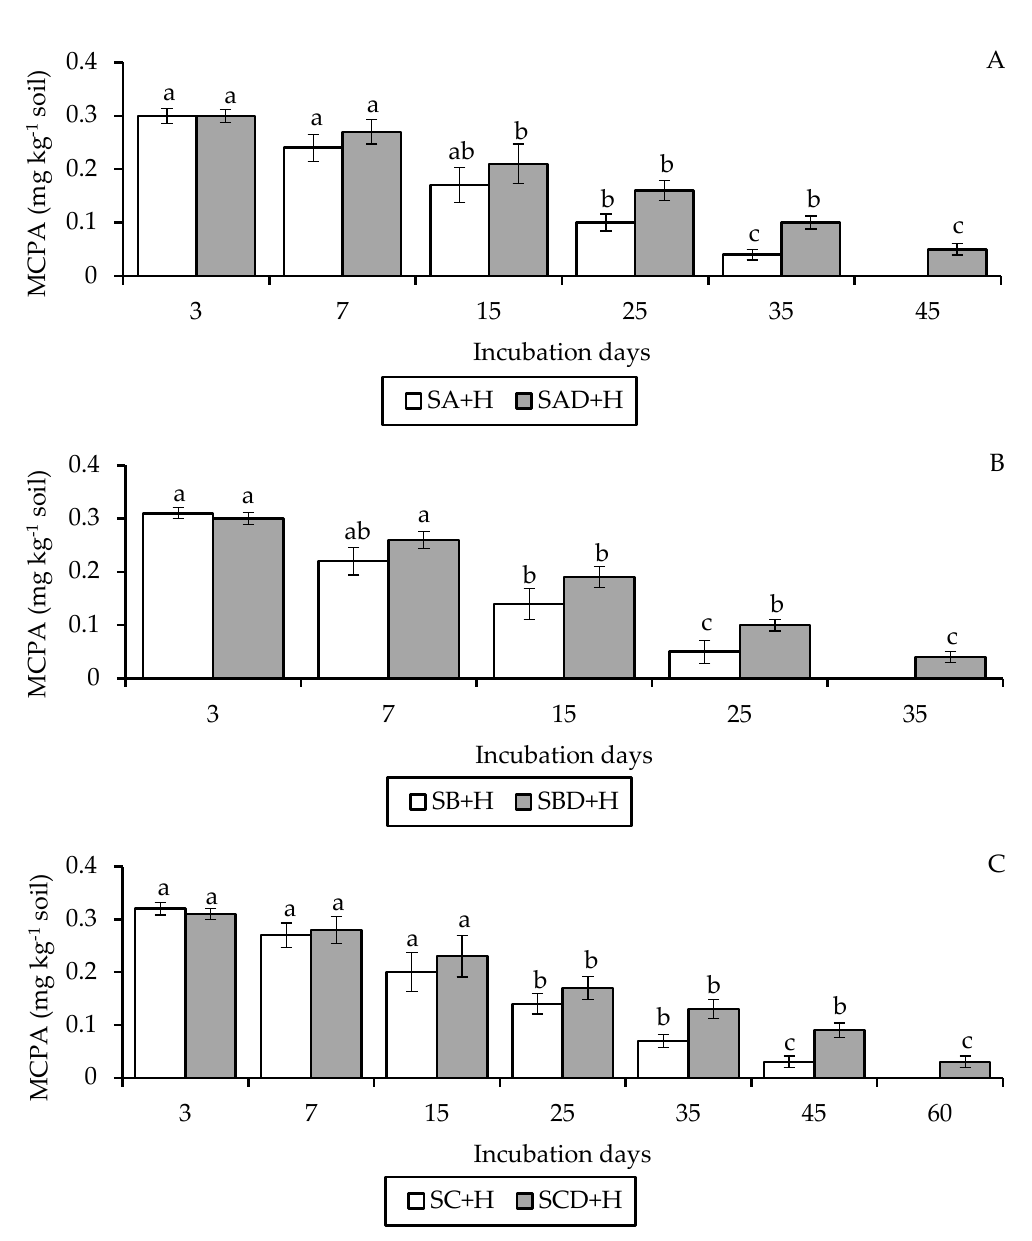
Figure 1. Evolution of MCPA herbicide (mean ± standard error, n = 3) in watered and non-watered soils during the experiment. Columns followed by the same letter(s) are not significantly different according to the Tukey test ( p > 0.05). ( A ) Typic Xerofluvent; ( B ) Typic Haploxeralf; ( C ) Vertic Chromoxert.